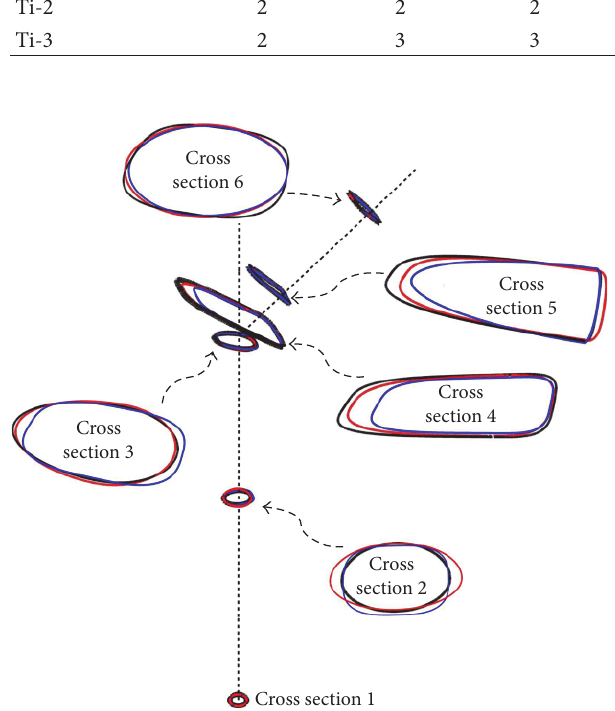
Figure 11: Change in the size and profile of the cross sections for all of Ti-1 (black), Ti-2 (red), and Ti-3 (blue) configurations.